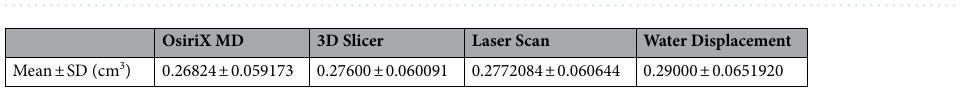
Table 1. In vitro validation. Comparison of CBCT segmented volumes (OsiriX MD and 3 D Slicer) and real volumes (Laser scan and water displacement method).